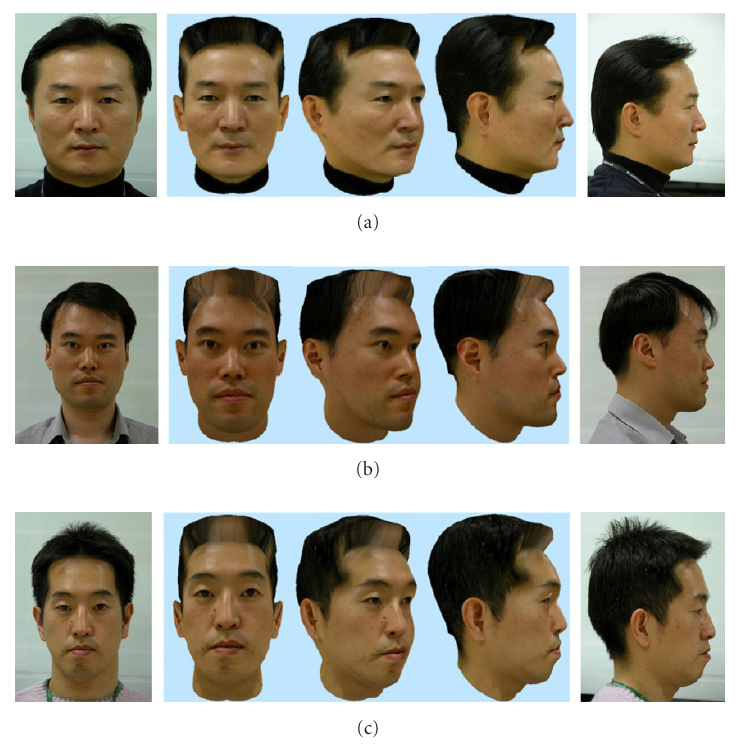
Figure 23: Final face models (Oriental men) generated by the proposed